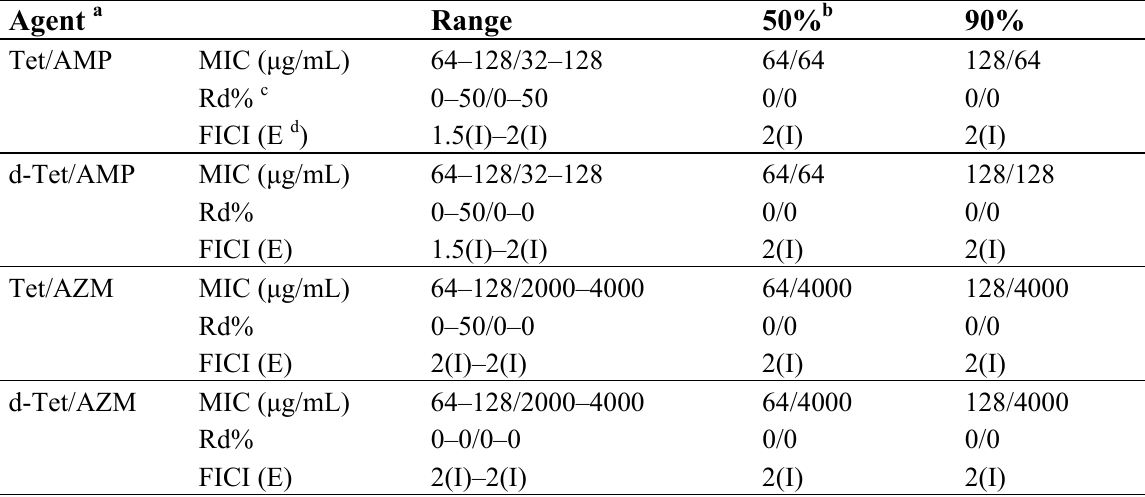
Table 2. MICs ( μ g/mL) and FIC indices (FICIs) of Tet and d-Tet in combination with four antibiotics against 10 clinical MRSA strains of SCCmec III